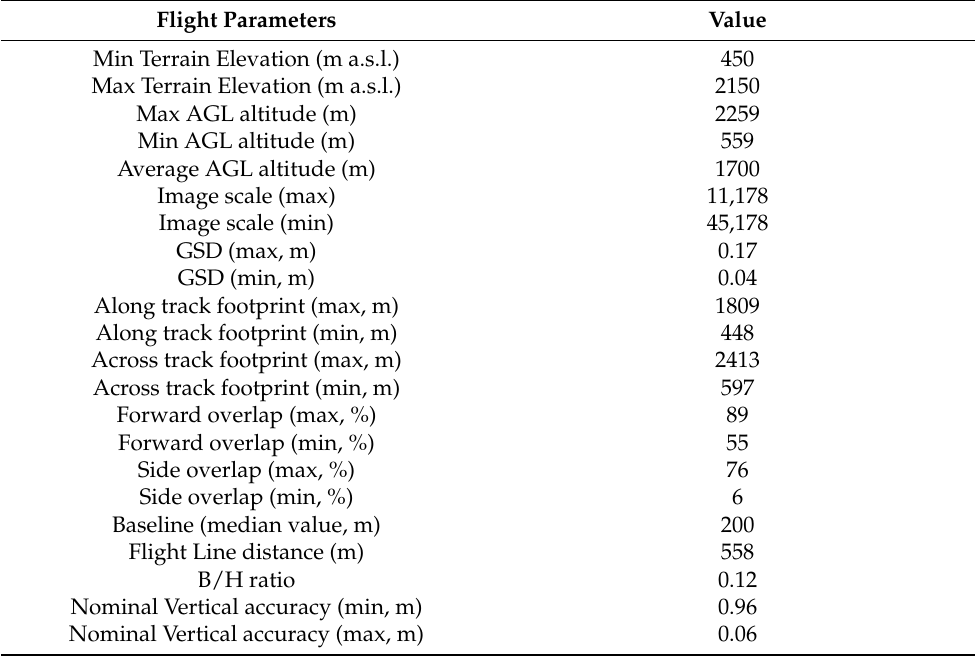
Table 3. A posteriori computed values of the main flight parameters. Values are obtained with refer- ence to the extreme geometric situations found when exploring and processing external orientation parameters as estimated by Agisoft Metashape for both blocks. Flight Parameters